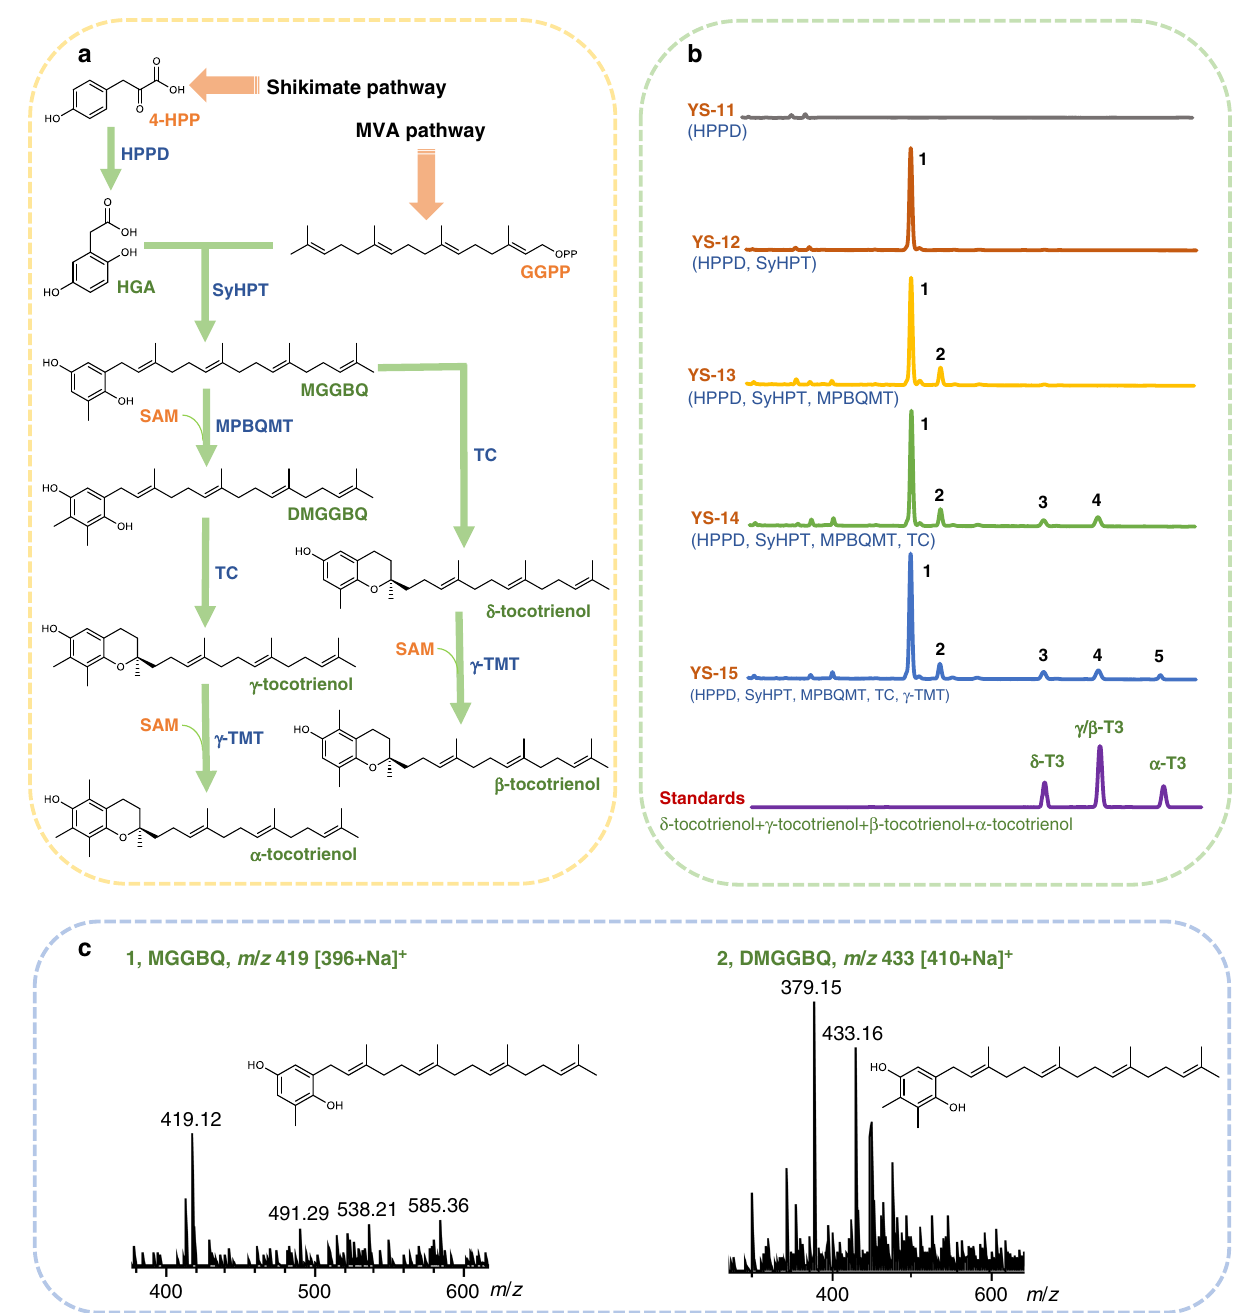
Fig. 1 Construction of tocotrienols biosynthetic pathway in S. cerevisiae . a Proposed tocotrienols synthetic pathway in S. cerevisiae . MVA pathway mevalonate pathway, 4-HPP 4-hydroxyphenylpyruvate; HGA homogentisic acid, GGPP geranylgeranyl pyrophosphate, MGGBQ 2-methyl-6-geranylgeranyl benzoquinol, DMGGBQ 2,3-dimethyl-5-geranylgeranyl-benzoquinone, HPPD 4-hydroxyphenylpyruvate dioxygenase, SyHPT homogentisate phytyltransferase, MPBQMT 2-methyl-6-phytylbenzoquinol methyltransferase, TC tocopherol cyclase, γ -TMT γ -tocopherol methyltransferase. b HPLC spectra of S. cerevisiae strains expressing the heterologous pathway genes. The retention time of γ -tocotrienol and β -tocotrienol was the same under the chromatographic conditions used. T3, tocotrienol. 1. MGGBQ; 2. DMGGBQ; 3. δ -T3; 4. γ / β -T3; 5. α -T3. c LC-MS analysis of MGGBQ and DMGGBQ in positive ion mode. Source data are provided as a Source Data fi